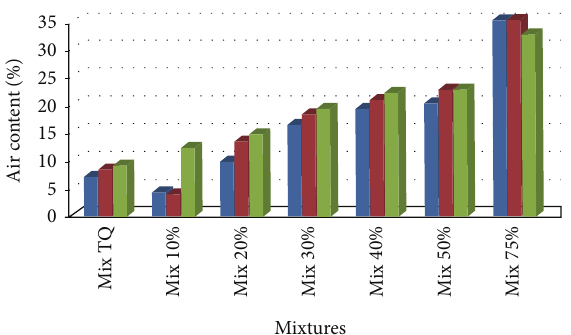
Figure 4: Air content of rubber cement composites.